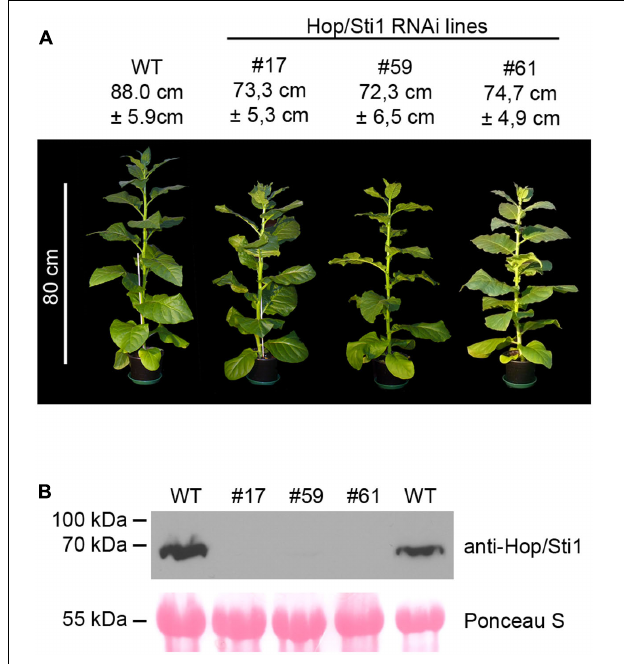
FIGURE 1 | Characterization of Hop/Sti1-RNAi plants. (A) Morphology of wild-type (WT) Nicotiana tabacum cv. Samsun NN plant and Hop/Sti1-RNAi plants from three independent lines. Height of the plants is given as average plus/minus standard deviation, calculated from ten individual plants per line. Difference between wild-type and transgenic plants is significant (Bonferroni-corrected student’s t -test, p -values of 4.51E–05, 7.14E–05 and 1.09E–04 for lines #17, #59, and #61, respectively) (B) Western blot analysis of Hop/Sti1 protein level in wild-type and Hop/Sti1-RNAi lines using an anti-Hop/Sti1 antibody. Hop/Sti1 is detectable in wild-type plants, but not in the transgenic lines. Ponceau S staining confirms equal loading of the gel.